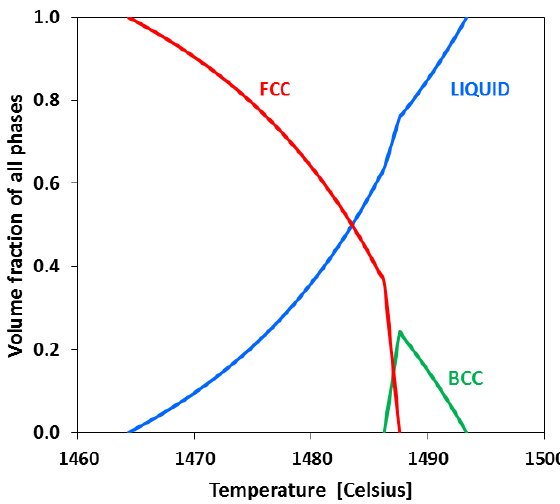
Figure 9. High temperature phase equilibria calculated with Thermo-Calc ® and the TCFE6 database for the composition (in wt. %) of the liquid estimated at the fusion line: C = 0.151, Cr = 4.43, Mn = 1.454, Mo = 0.26, N = 0.014, Ni = 2.842, Si = 0.393, Fe = bal.